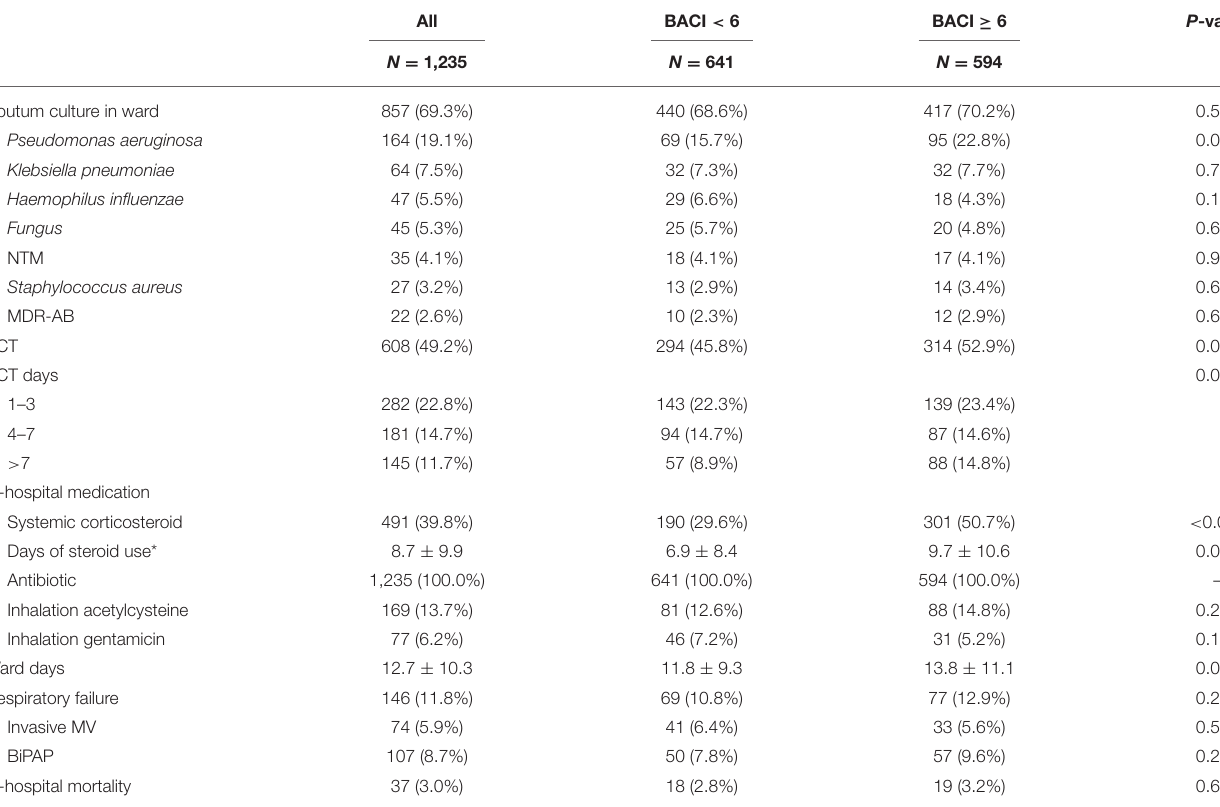
TABLE 2 | Main clinical outcomes of hospitalization.